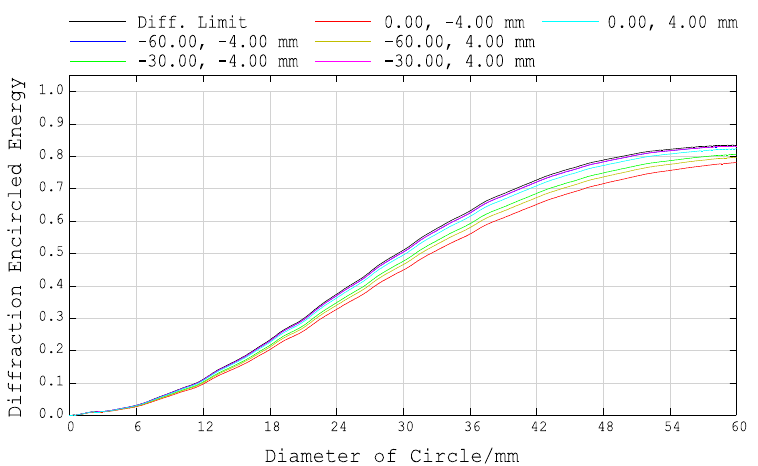
Figure 10. Diffraction encircled energy curves for the fields (( − 60 mm, − 4 mm), ( − 30 mm, − 4 mm), (0 mm, − 4 mm), ( − 60 mm, 4 mm), ( − 30 mm, 4 mm), and (0 mm, 4 mm)) along the slit for the central wavelength of 10 μm.